Question: Provide a publication-style caption for this figure.
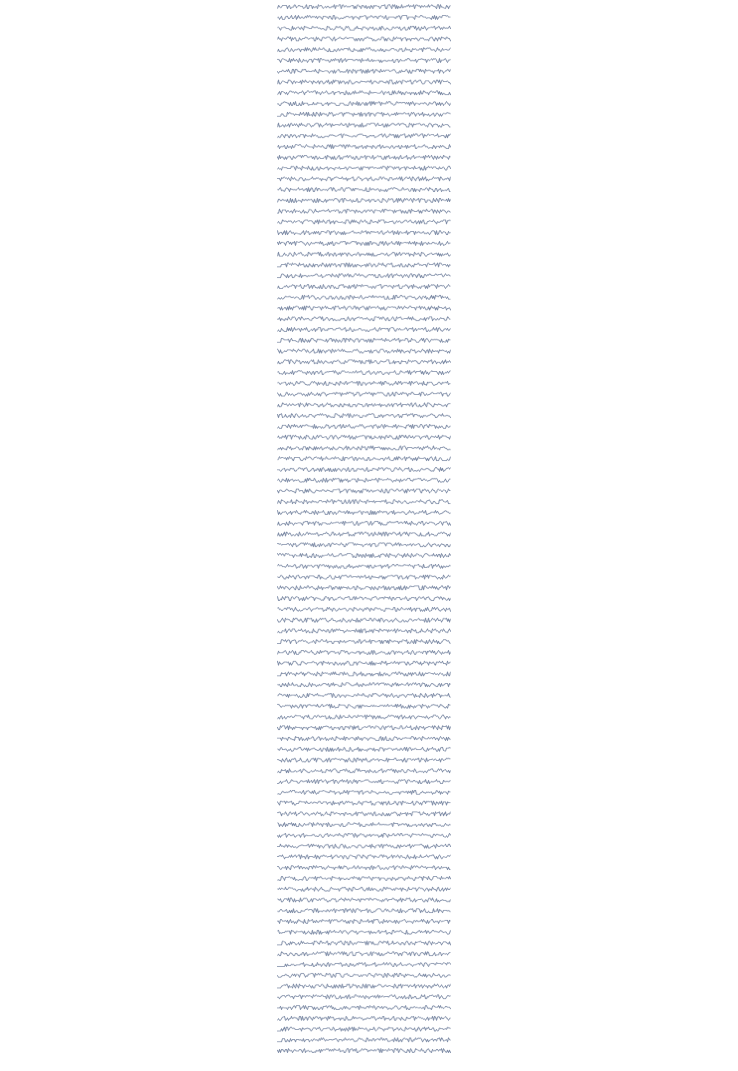
Answer: 100 trendlines for all NIST tests p-values after applying between 0 and 99 coning operations on a vector of length 3751, with a pattern of all 1’s